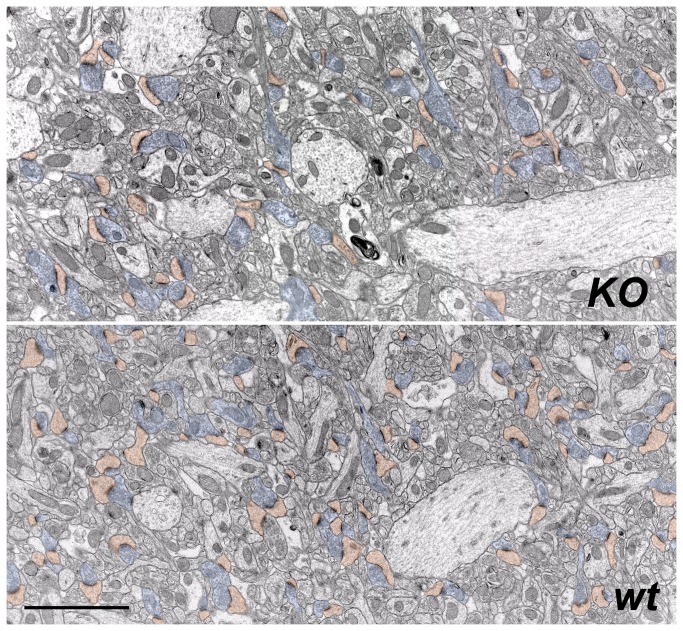
Overview of ultrastructural changes associated with deletion of WAVE-1.Representative low-magnification electron micrographs of synaptic neuropil in stratum radiatum of CA1 hippocampus, showing postsynaptic spines (orange) and presynaptic boutons (blue) in material from KO (A) and wt mice (B). Scale bar: 5 µm.